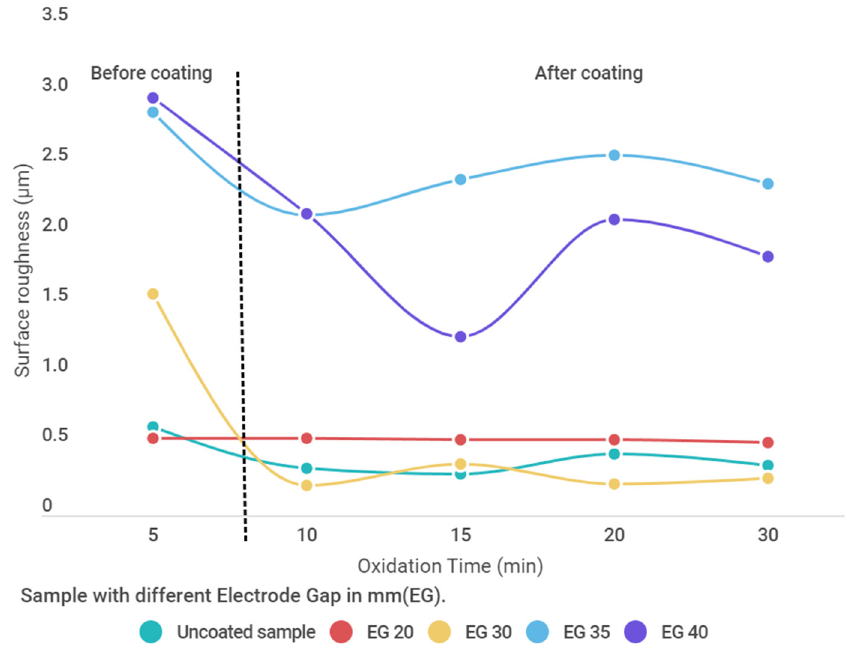
Figure 13. Elemental distribution SEM image for powder residue after experimentation. ( a ) Element distribution of Al,C,O , ( b ) Distribution of C ( c ) Distribution of Al , ( d ) Distribution of O , ( e ) Overall elemental distributions.